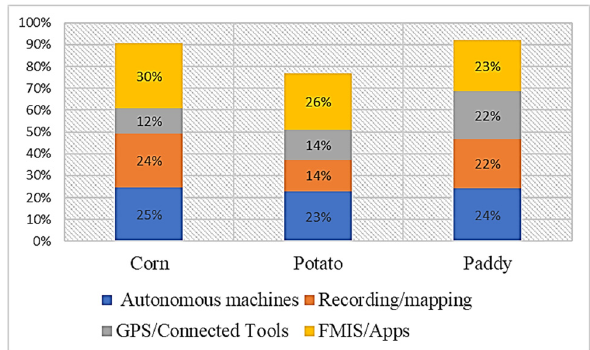
Figure 6: Types of SFTs that are considered most useful for which types of agricultural commodities they cultivate, by size class, and